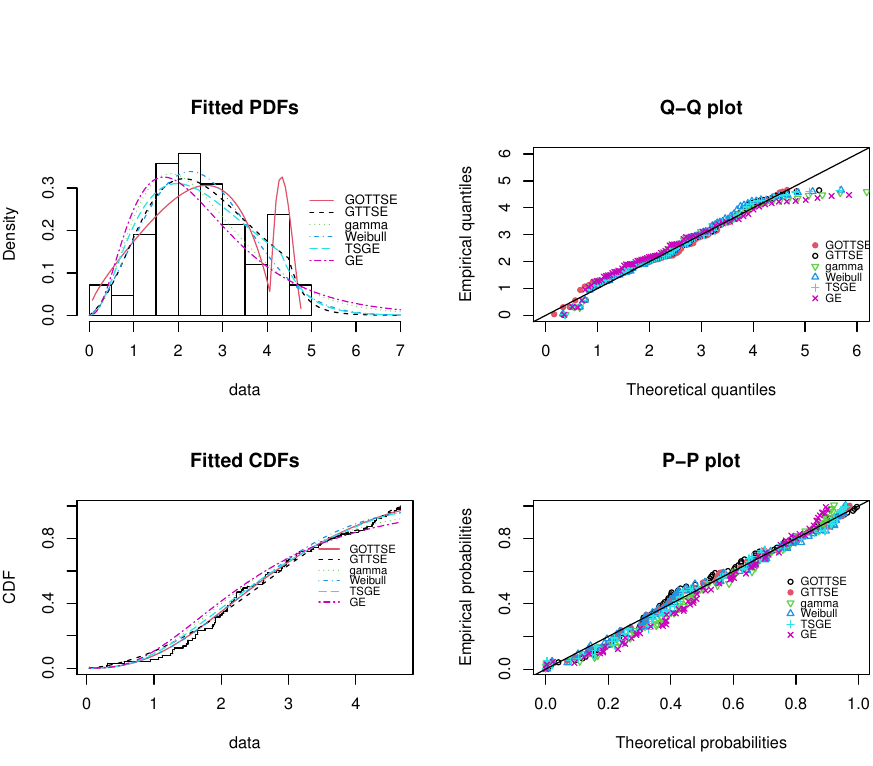
Figure 9 – Histogram, fitted pdfs, empirical and fitted cdfs, Q-Q plots and P-P plots of the GOTT- E distribution and other fitted distributions for the first data set.